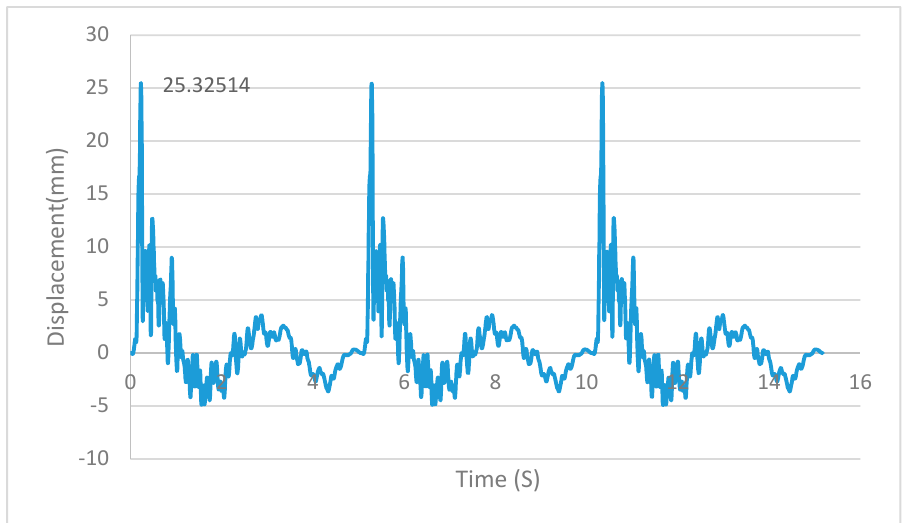
Figure 11. The X-displacement series of the Friuli earthquake, Italy 1981 (Peer Ground Motion Database [43]).